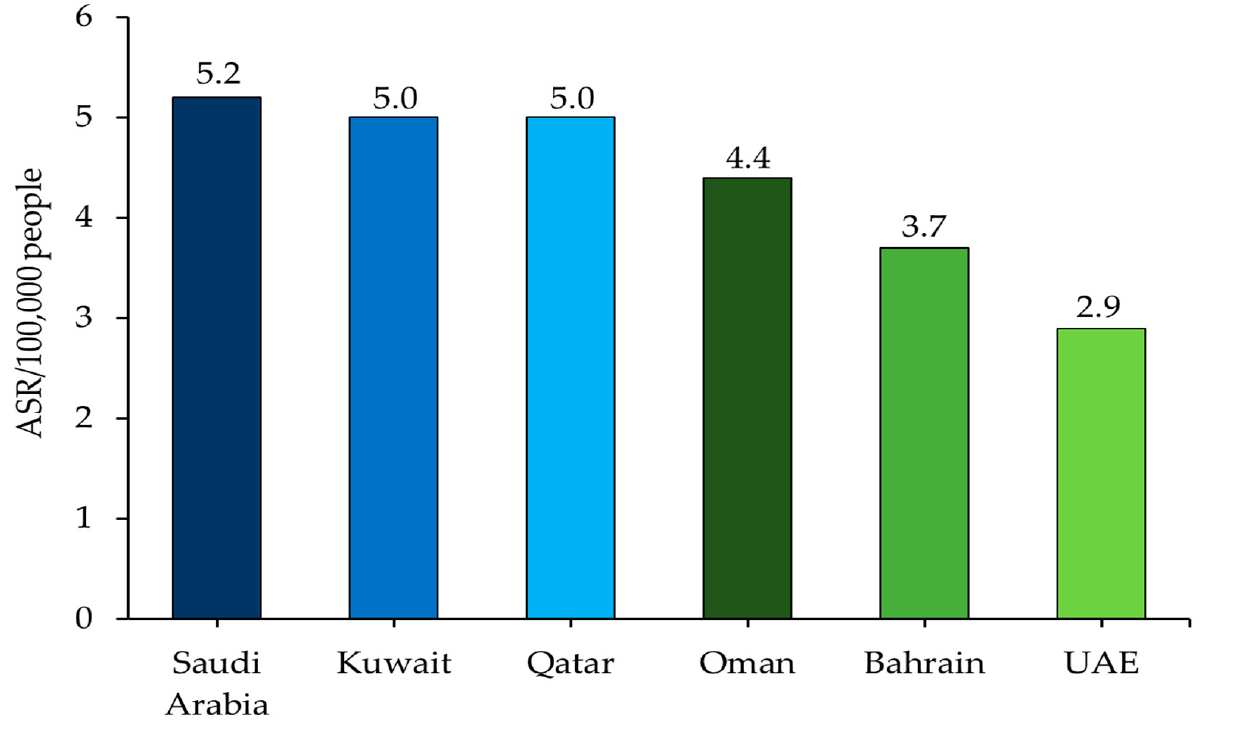
Figure 1. HCC incidence rates in the GCC countries: GLOBOCAN 2020. ASR, age-standardized incidence rate; GCC, Gulf Cooperation Council; HCC, hepatocellular carcinoma; UAE, United Arab Emirates.